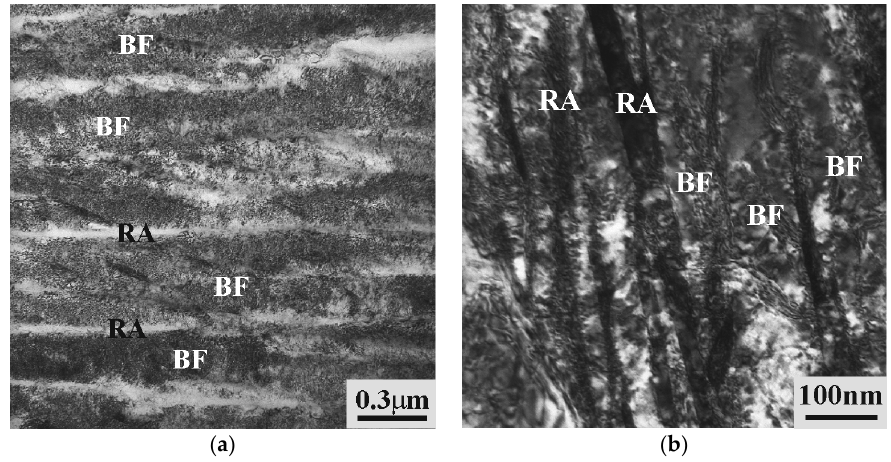
Figure 1. TEM (Transmission Electron Microscopy) micrographs of the microstructure formed after 200 °C ( a ) and 350 °C ( b ) isothermal treatment. RA is retained austenite and BF is bainitic ferrite.